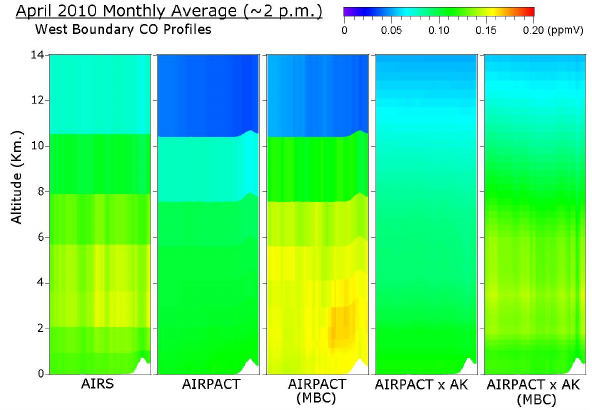
Fig. 12. April 2010 monthly average ( ∼ 02:00 p.m. PST) carbon monoxide profiles along the west border of AIRPACT-3 for (a) AIRS level-2 v5, (b) original AIRPACT-3, (c) AIRPACT-3 MBC, (d) original AIRPACT-3 convolved with the AIRS averaging kernel, and (e) AIRPACT-3 MBC convolved with the AIRS averaging ker- nel. Note that AIRPACT-3 values shown are the predicted CMAQ concentrations, and not boundary conditions themselves. For refer- ence, x-axes run from south to north: offshore northern California (left) to Vancouver Island (right).